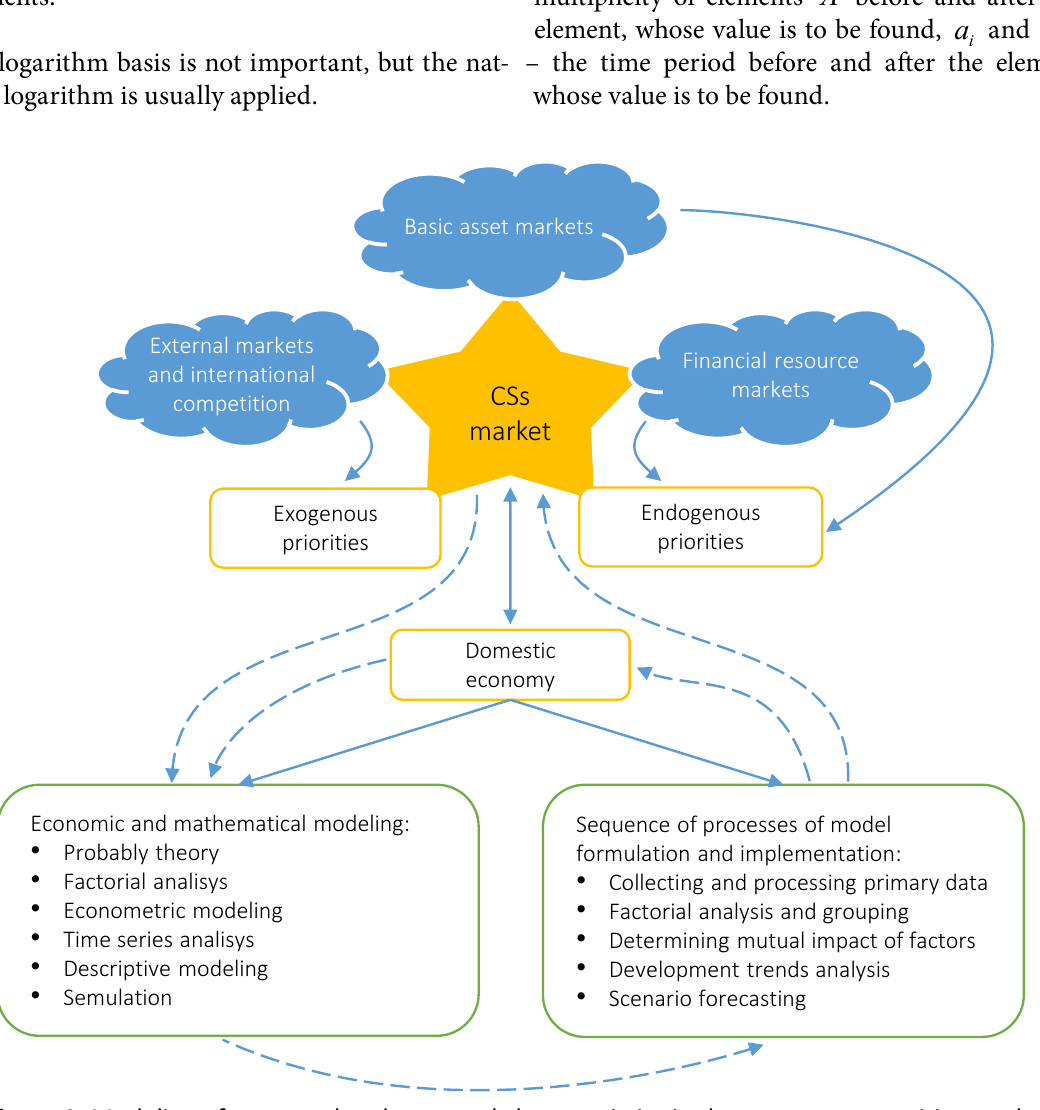
Figure 1. Modeling of structural and temporal characteristics in the corporate securities market